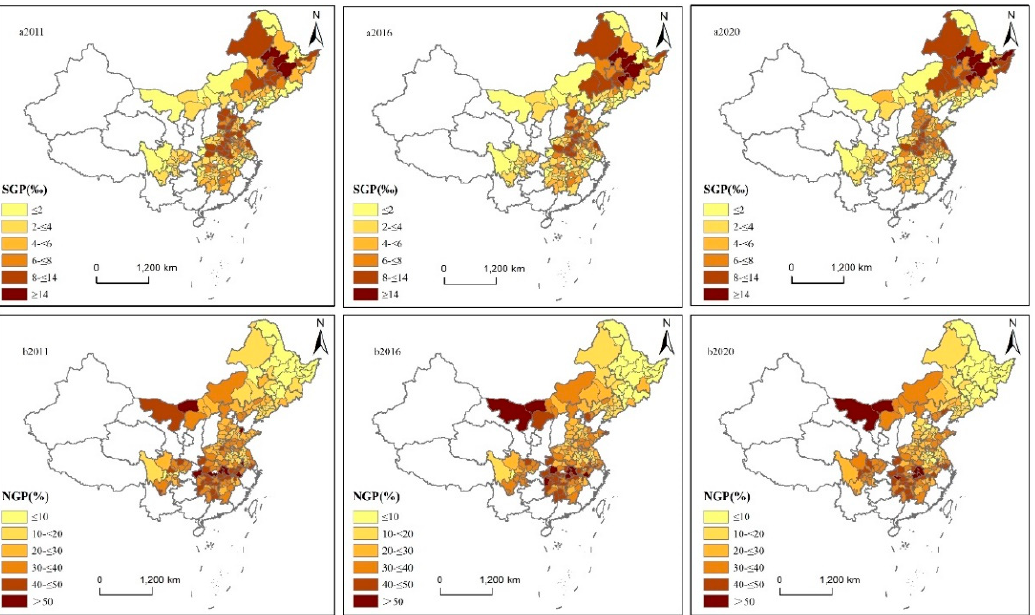
Figure 4. The ratio of non-grain production and the proportion of grain production to total national production in 2011, 2016, and